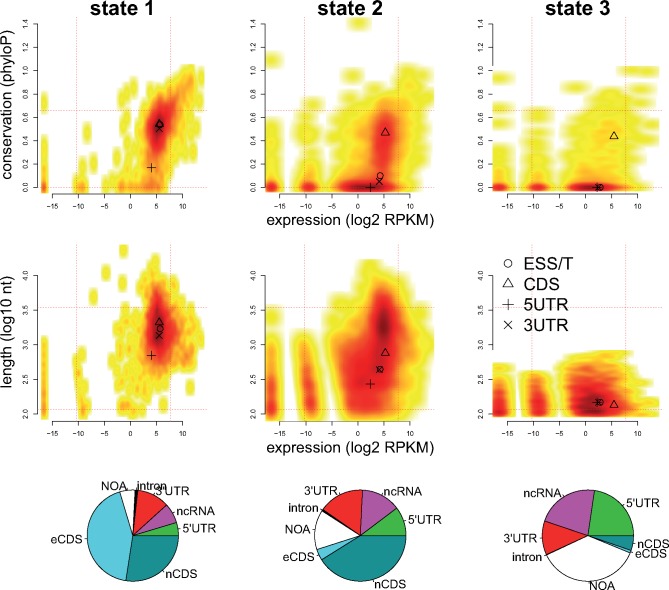
HMM-defined elements describe functional genomic outputs. Density plots describe various characteristics of HDEs, from left showing S1, S2, and S3 HDEs. Conservation (y axis, top row) levels are mean phyloP measures from four Schizosaccharomyces species. HDE lengths (y axis, middle row) are shown on a log10 scale. Expression levels (x axes) are RNA-Seq RPKMs from proliferating cells. Dashed horizontal and vertical lines show the 5th and 95th percentiles of conservation, expression levels or lengths. The positions of symbols (circle and triangle) indicate the median positions within each state for essential transcripts (ESS/T), coding regions (CDS), and 5′/3′-UTRs. For example, the few conserved S3 sites are coding regions. The bottom row shows the proportions of bases in S1, S2, and S3 HDEs that are annotated as introns, 3′-UTRs, ncRNAs, 5′-UTRs, nonessential coding regions (nCDS), essential coding regions (eCDS) or have no annotation (NOA). For example, state 1 HDEs often overlap essential coding regions, but S3 HDEs seldom do.